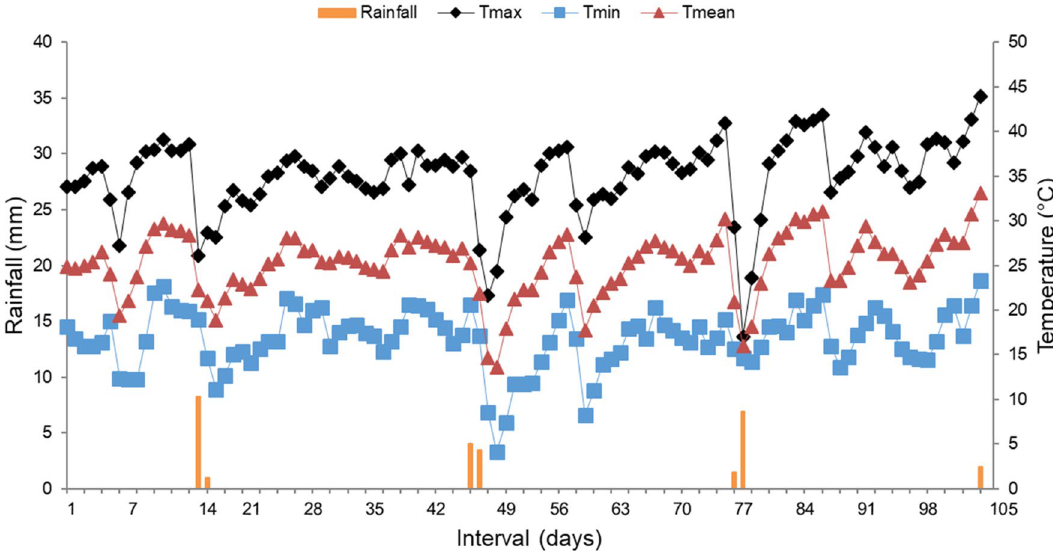
Figure 1. Daily rainfall and daily minimum (Tmin), daily, mean (Tmean) and daily maximum (Tmax) ambient temperature throughout the N 2 O and CH 4 emission sampling period. Data were retrieved from the Agrometeorological Station, Department of Exact Sciences (FCAV/UNESP), located at 1 km from the experimental Gas emissions. Mean temperature during the N 2 O and CH 4 emission sampling period was 20 °C; the low- est (3.3 °C) and highest (35.2 °C) temperatures were recorded close to sampling day 49 and on the last sampling day, respectively. Cumulative precipitation throughout the experimental period was 33.6 mm, occurring over 7 different days (Fig. 1). Daily mean N 2 O and CH 4 fluxes varied from −62 to 318 µg N 2 O m 2 h −1 and from −125 to 321 µg CH 4 m 2 h −1 , respectively, during the experimental period (Fig. 2). Highest peak of N 2 O emission was observed in the 21st day, on all treatments. On the same day, an increase in CH 4 fluxes was also observed. Differences in N 2 O and CH 4 fluxes among treatments occurred in some days of evaluation and were not consistent along the studied period. Protein sources did not affect cumulative CH 4 emission from animal manure (P > 0.05) (Table 2). However, the manure of animals fed RUP sources resulted in a higher cumulative N 2 O emission than that of animals fed the RDP source (P = 0.030). Emissions from manure of cattle fed CGM were almost double and emissions from manure from cattle fed BSM (P = 0.038) were quadrupled compared to SM-fed cattle. An interaction between sampling time and protein source was observed for DM, OM, N, C and NH 4 + (Table 3, Fig. 3). The manure of animals fed CGM presented a lower N content and higher NH 4 + than that of animals fed SM on day 42 (P < 0.001), while on day 63 higher values of N and NH 4 + were observed for the manure of animals fed CGM in relation to BSM (P = 0.002 and P = 0.010 respectively) and SM (P = 0.004 and P < 0.001, respectively). The manure of animals fed SM showed a higher C content than that of animals fed source of RUP on day 42 (P = 0.001). The manure of animals fed SM showed a higher C/N than that of animals fed RUP (P = 0.001). Nitrate content of the analyzed samples was not detectable. There were no correlations of manure gases (N 2 O and CH 4 ) emissions with N, C, C/N ratio, DM, OM, and NH 4+ (P > 0.05) (Table 4). Nitrogen was positively correlated with C (P < 0.001) and OM (P < 0.002). Carbon was positively correlated with C/N ratio (P < 0.001). Ammonium was positively correlated with OM (P = 0.045). A positive correlation was observed between CH 4 and C/N ratio on day 42 (P = 0.025), and between CH 4 and NH 4+ on day 63 (P = 0.001). On day 105, N 2 O was positively correlated with DM (P = 0.018) and NH 4+ (P = 0.008) (Table 5). NH emission. Mean temperature during the NH 3 3 emission sampling period was 25 °C. The lowest (15.2 °C) and highest (37.3 °C) temperatures were recorded on the first sampling day and on day 19, respectively. Cumula- tive precipitation throughout the experimental period was 320.5 mm, occurring on 30 different days (Fig. 4). Manure from all treatments showed the highest daily mean NH 3 emission on the first day of evaluation (Fig. 5). Subsequently, NH 3 emission decreased until the fourth day of evaluation under all treatments. From the 19th day, a new peak of NH 3 emission was observed under all treatments. The SM treatment presented a small increase in NH 3 emission on days 38 and 51, while the BSM and CGM treatments presented a decrease in emission. Ammonia emission under all treatments completely ceased on the 77th day. From day 13 to 25, cumulative NH 3 emission under the SM treatment was higher than that under the BSM and CGM treatments. However, after this period, no differences were observed among the treatments. There were no significant differences in cumulative NH 3 emission from the manure during the evaluated period and manure content of DM, OM, N, and C (P > 0.05) among the three protein sources (Table 6). Likewise, there were no differences in the C/N ratio of the manure between the RDP and RUP sources (P = 0.491). However, the manure of animals fed BSM showed a higher C/N ratio than that of animals fed CGM (P < 0.001). The manure